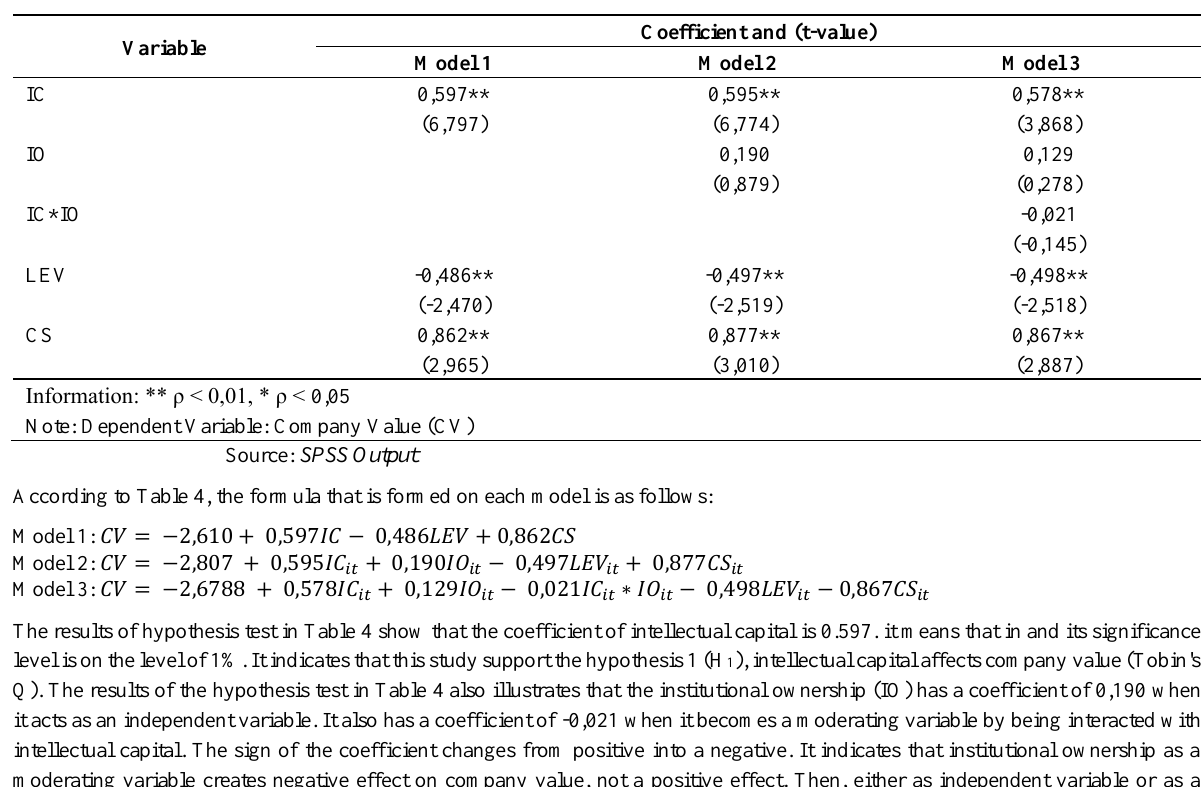
Table 4: Results of Regression